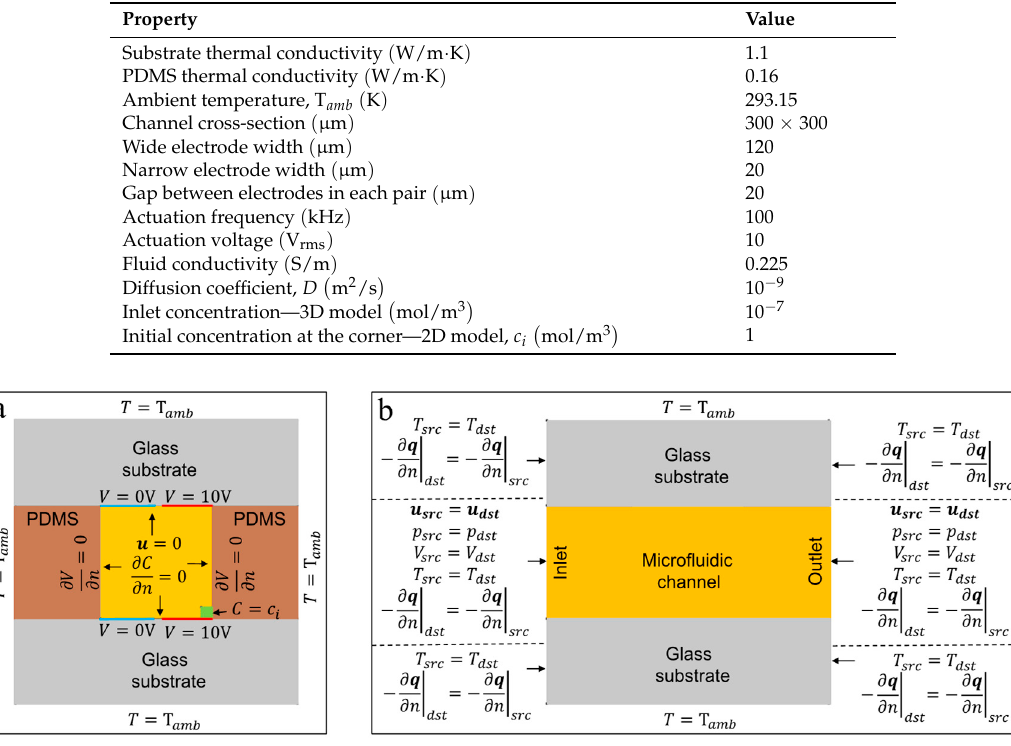
Figure 1. The boundary conditions used for different domains (i.e., electrical, thermal, laminar flow, and species transport) in the 2D modeling of the ACET device. ( a ) shows the cross-sectional view of the device. ( b ) shows the side view of the device. The parameters q and T amb are the heat flux and ambient temperature, respectively. The periodic quantities are referred to using src and dst subscripts to represent source and destination , respectively. The schematics are not drawn to scale. Note that the electrode dimensions (red and blue) and the species release area (green) in ( a ) are shown as an example.